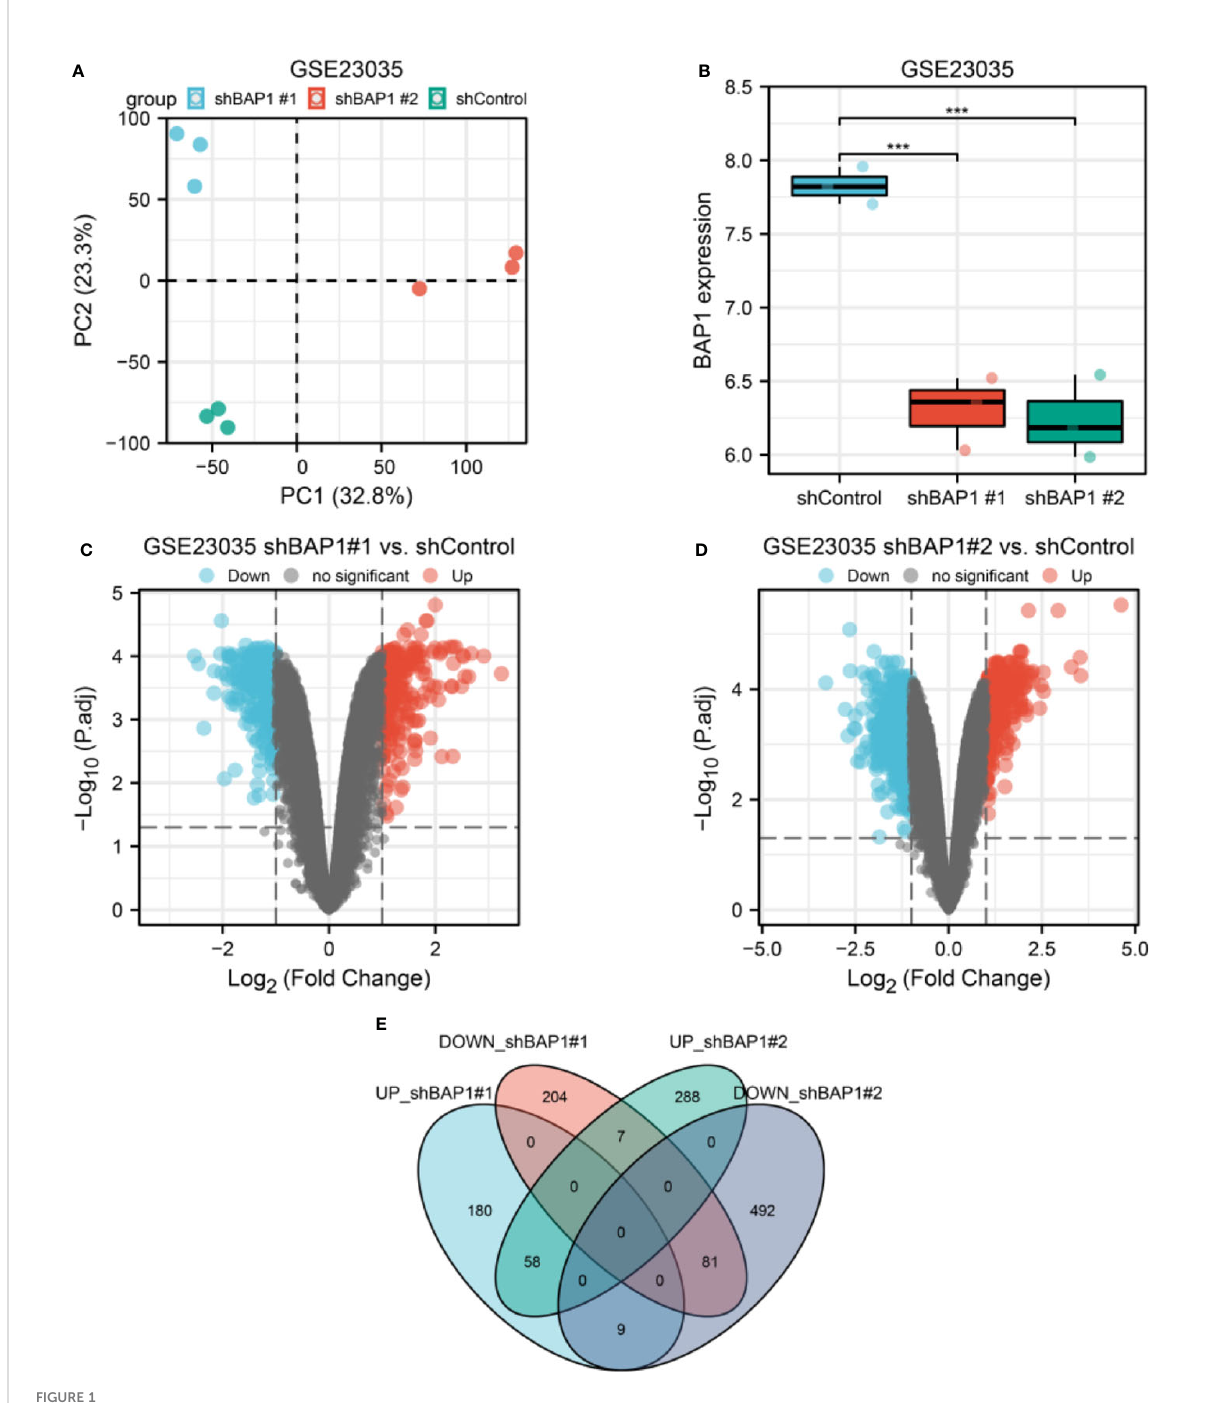
FIGURE 1 DEGs screening in GSE23035. (A) PCA plot of three groups of osteosarcoma cell samples in GSE23035. (B) BAP1 expression in shControl, shBAP1#1 and shBAP1#2 samples. (C) A volcano plot showing DEGs between shControl and shBAP1#1 groups. (D) A volcano plot showing DEGs between shControl and shBAP1#2 groups. (E) Overlapped DEGs between shBAP1#1 and shBAP1#2 were screened via a venn diagram ***p <